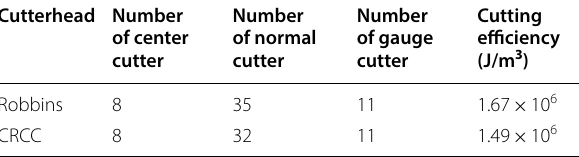
Table 5 Cutting efficiency of two cutterheads Cutterhead Number of